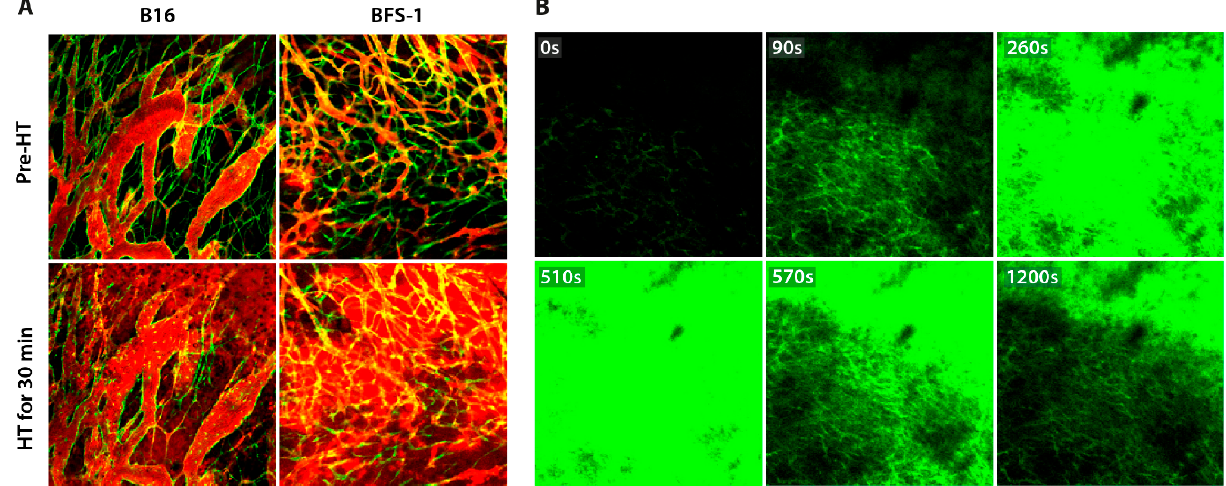
Figure 8. Hyperthermia (HT)-mediated intratumoral liposomal drug delivery. ( A ) HT (41.0 ◦ C; 30 min) triggered rhodamine- labelled long circulating liposome (red) extravasation through murine B16BL6 melanoma or murine BFS-1 fibrosarcoma tumor vasculature (green). At physiological temperature, extravasation hardly occurred. HT application increased vascular permeability and enabled the extravasation of liposomes. ( B ) HT (42.2 ◦ C; 5 min) triggered drug release (green) from thermosensitive liposomes (TSLs) in B16BL6 murine melanoma. TSLs released content (carboxyfluorescein; CF) when exposed to HT (39.5 ◦ C or higher), resulting in rapid distribution of CF throughout the tumor. However, TSLs appeared stable at a physiological temperature and no CF was released when the intratumor temperature returned to base- line.